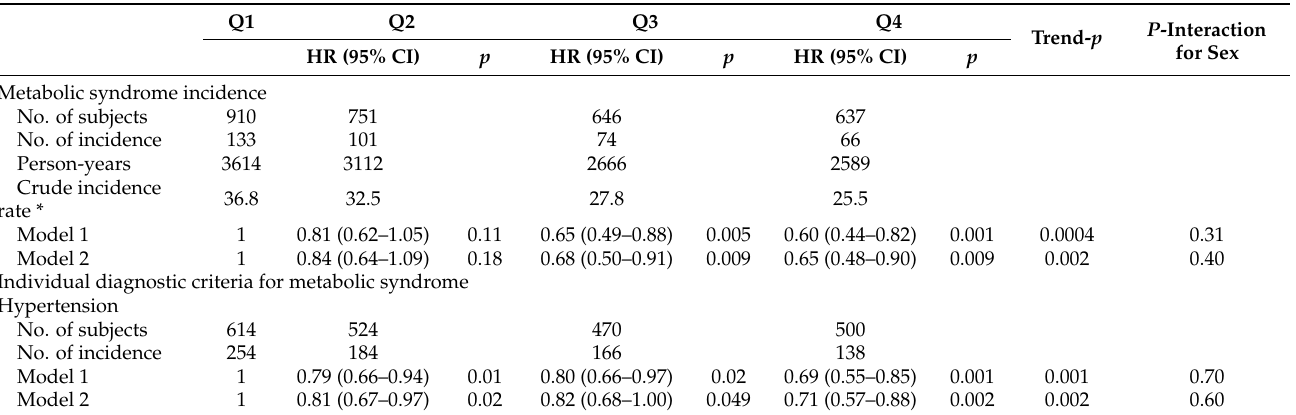
Table 4. Hazard ratios and 95% confidence intervals for the incidence of metabolic syndrome and its components according to the quartiles of the Healthy Dietary Pattern score for the Aichi Workers’ Cohort,